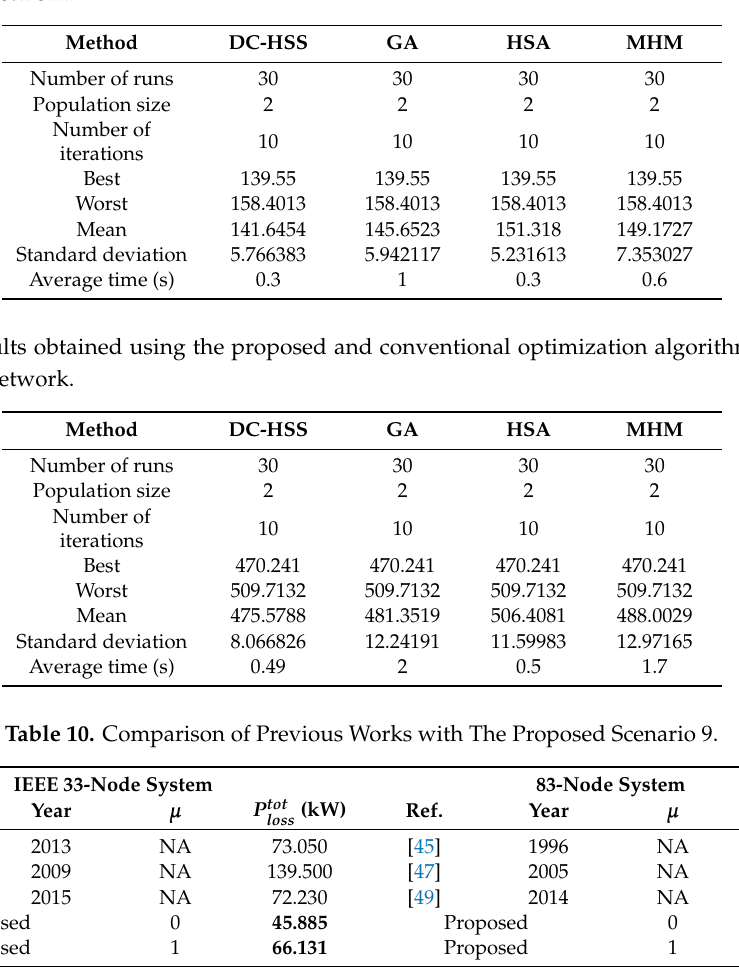
Table 8. Results obtained using the proposed and conventional optimization algorithms: IEEE 33-node distribution network.